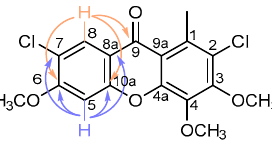
Figure 2. Relevant correlations of 2,7-dichloro-3,4,6-trimethoxy-1-methyl-9 H -xanthen-9-one 18 HMBC spectra.